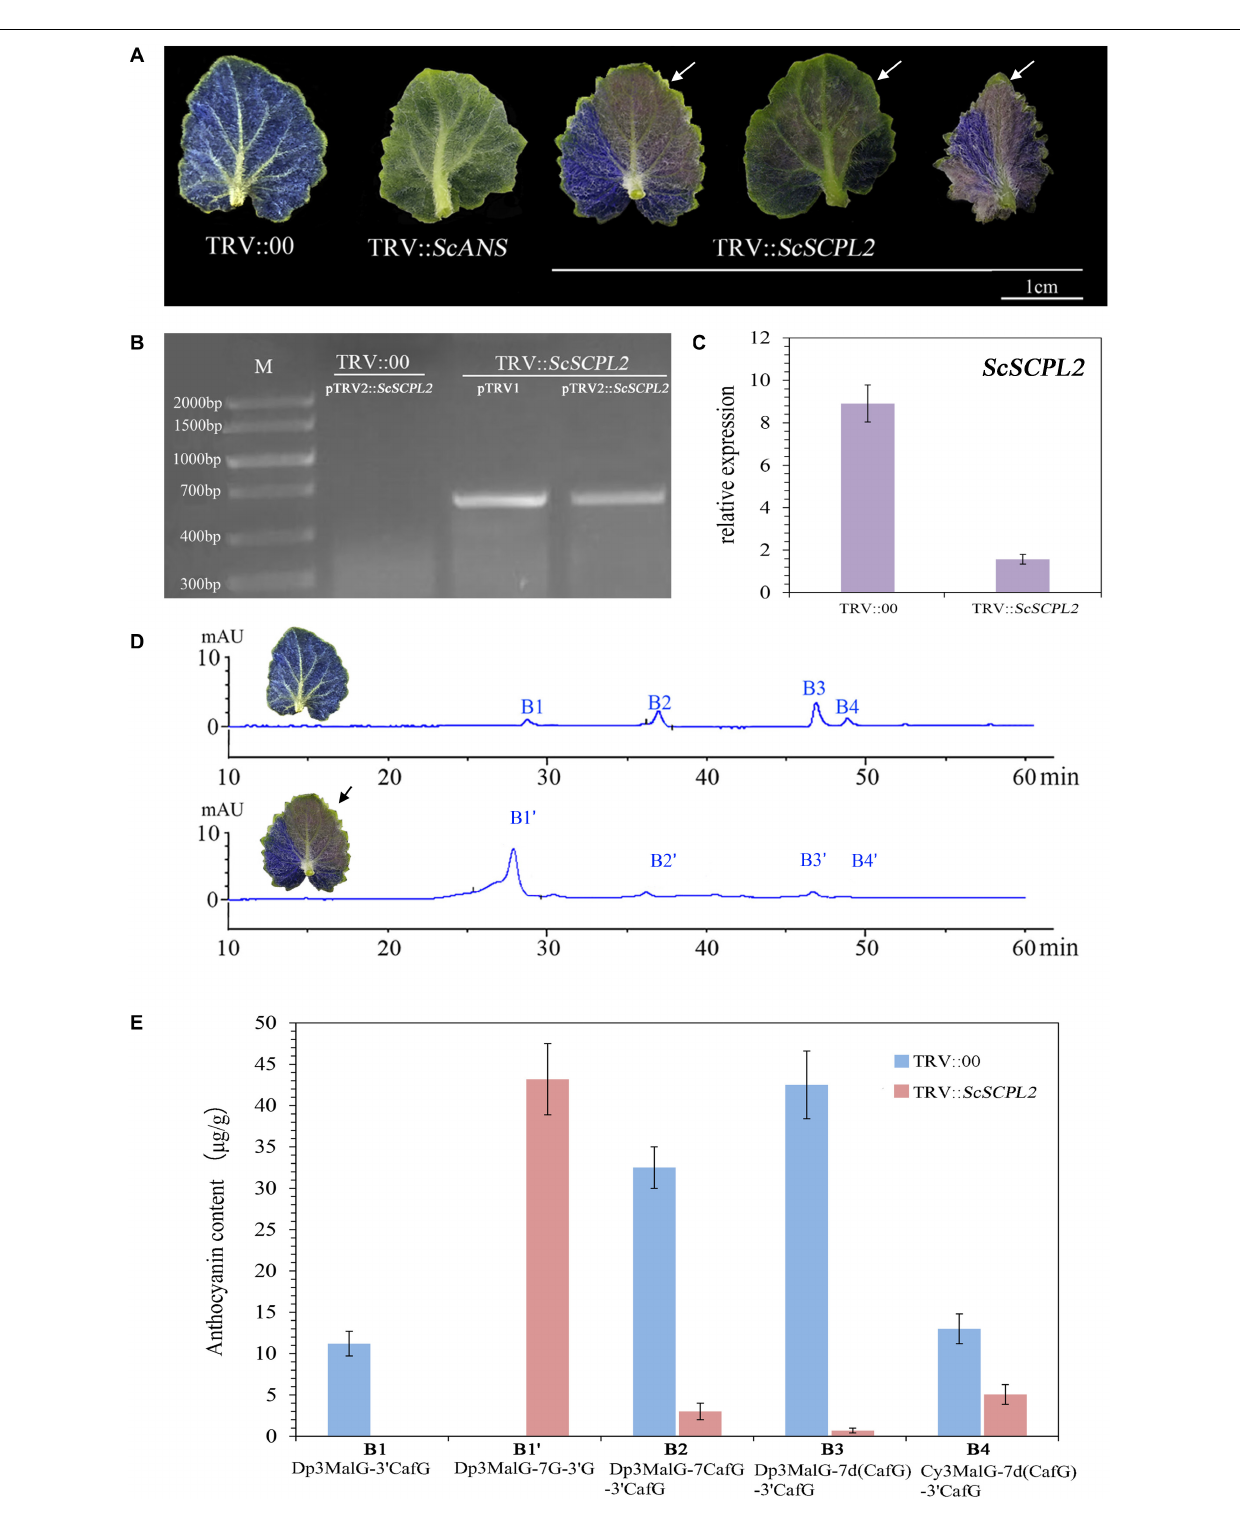
Frontiers in Plant Science |